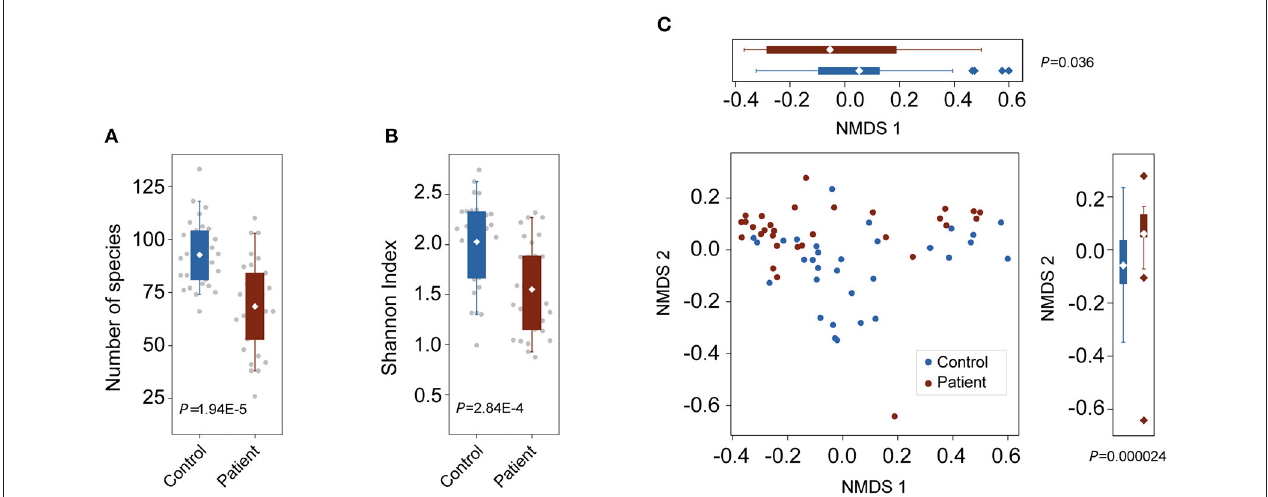
FIGURE 1 | Changes in bacterial diversities in gut microbiota in TB patients compared with healthy controls. C, control; P, patients. (A) Comparison of the numbers of species in the two groups. P = 1.94E-5, Wilcoxon signed-rank test. (B) Comparison of α -diversity (as assessed by the Shannon index). P = 2.84E-4, Wilcoxon rank-sum test. (C) NMDS plots based on the relative abundance of genera. Values of NMDS axes 1 and 2 for three groups were box plotted on the top and the right,